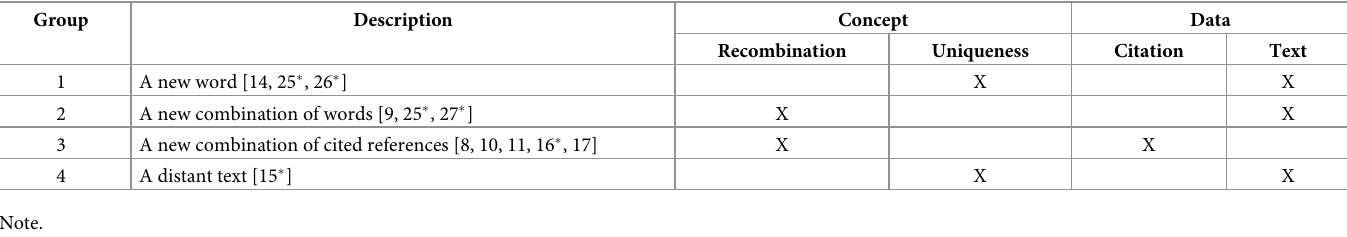
Table 1. Previous novelty